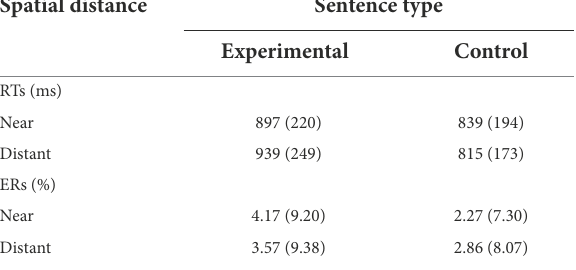
TABLE 1 Mean RTs (in milliseconds) and ERs to the key justice probes as a function of spatial distance and sentence type, with standard deviation in